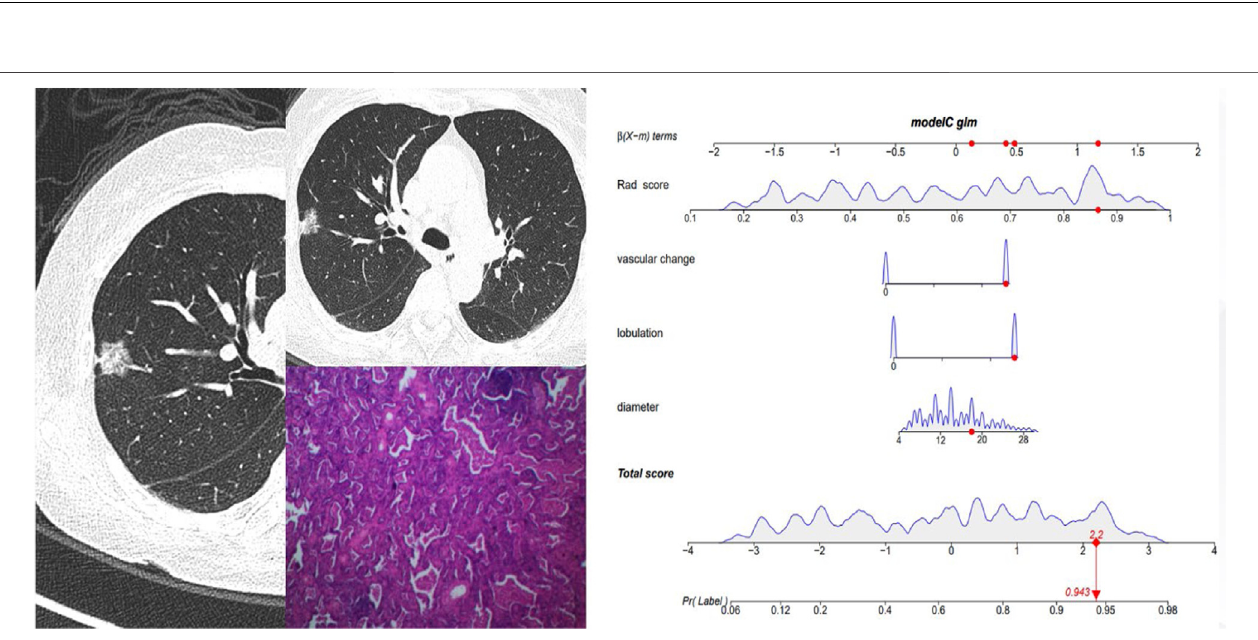
FIGURE 5 | Female, 57 years old; CT showed a pGGN of 11 mm in the right upper lobe, with no signi fi cant lobulation and vascular change, and the Rad score of pGGN was 0.491. Interactive nomogram showing that the IAC risk probability of this nodule was 0.249. The case was con fi rmed as AAH.